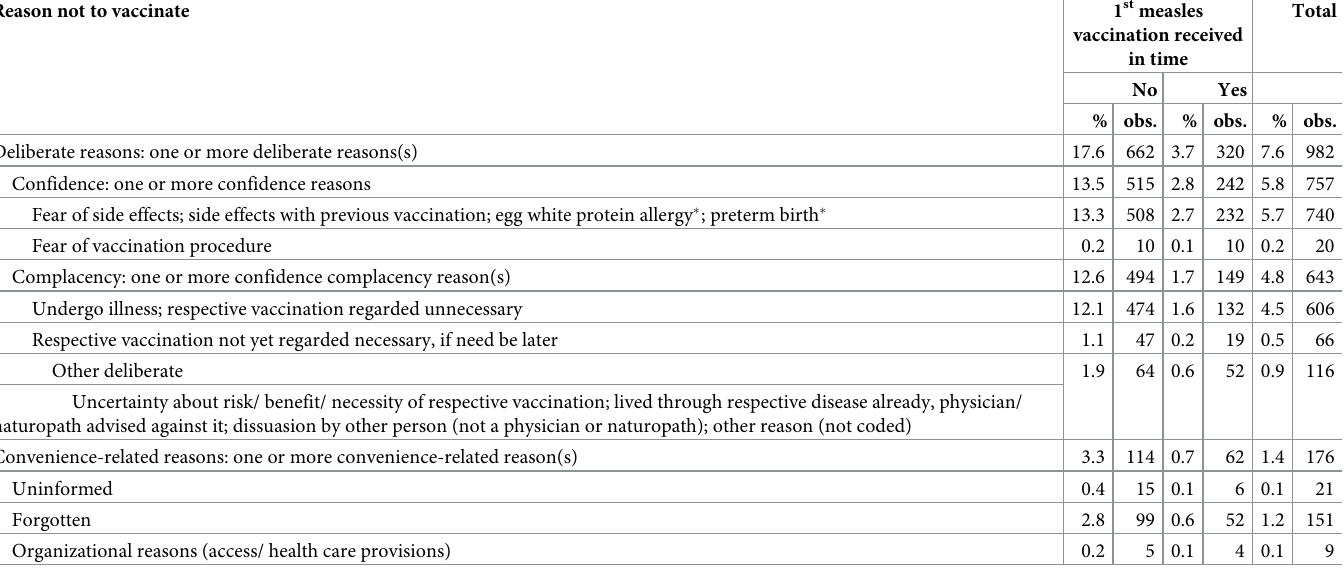
Table 1. Share of parents reporting reasons to not vaccinate by measles vaccination status of child at 24 months. KIGGS data, shares weighted, obs. not weighted, N = 13,507 observations; a small minority of 82 parents gave deliberate as well as convenience-related reasons, from 757 parents who gave confidence reasons 475 also gave complacency reasons. � Preterm birth and egg white allergies are not considered contraindications to most